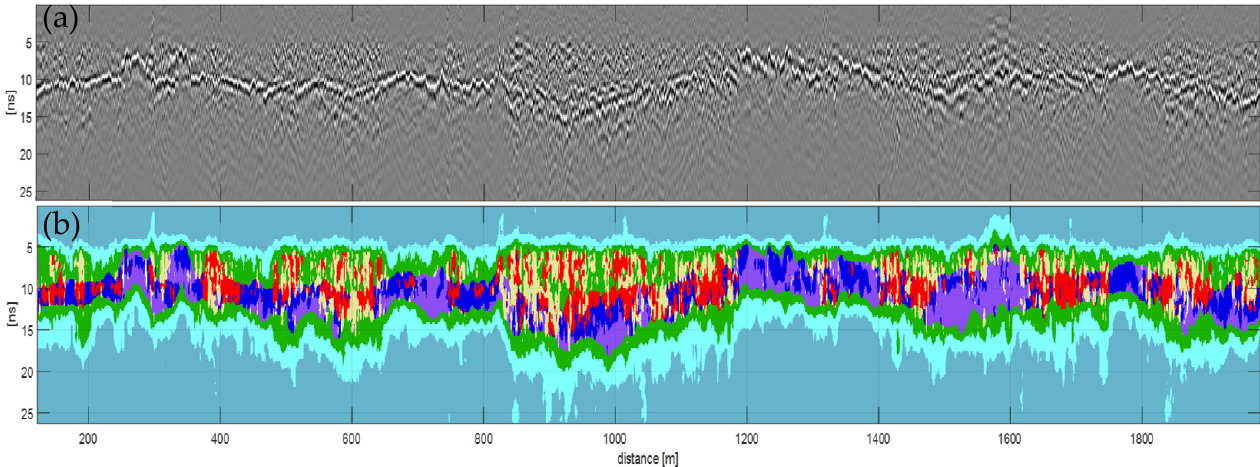
Figure 9. ( a ) Original radargram; ( b ) segmentation result of the proposed method, where different colors represent different relevant radargram structures based on objectifiable criteria (scatterplot coordinates) defined by railway radargram experts (e.g., blue/purple regions: track planum; yellow/red regions: indications of ballast fouling).